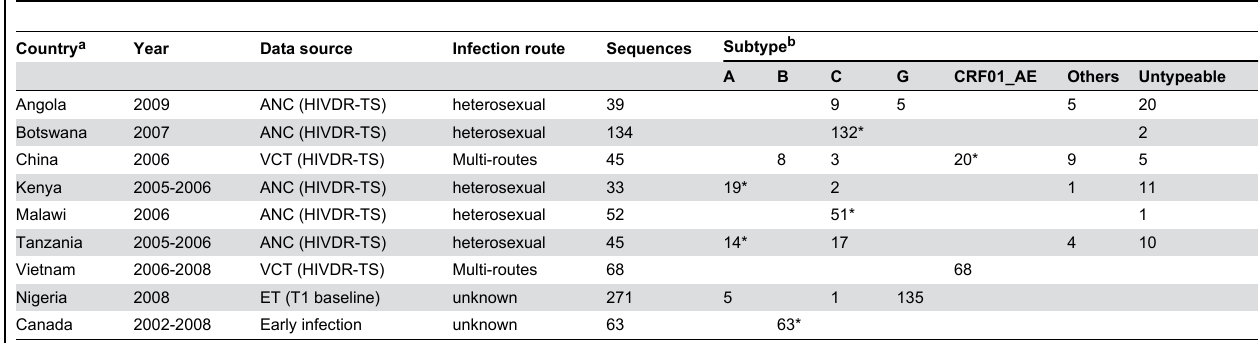
Table 1. Characteristics of sequence datasets and subtyping in partial HIV-1 pol